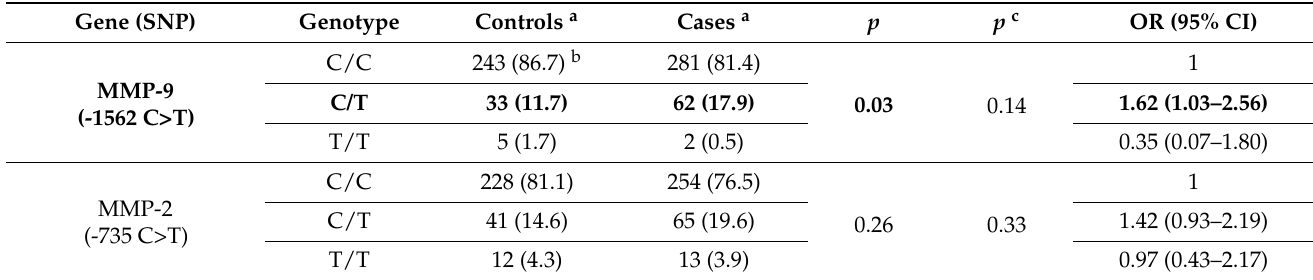
Table 3. Genotypic frequencies of the studied polymorphisms.